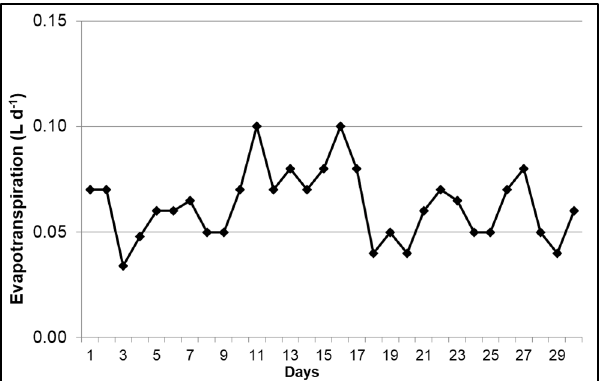
Figure 1. Evapotranspiration (L d − 1 ) in zinnia 100% FC during the experimental period (30 days).